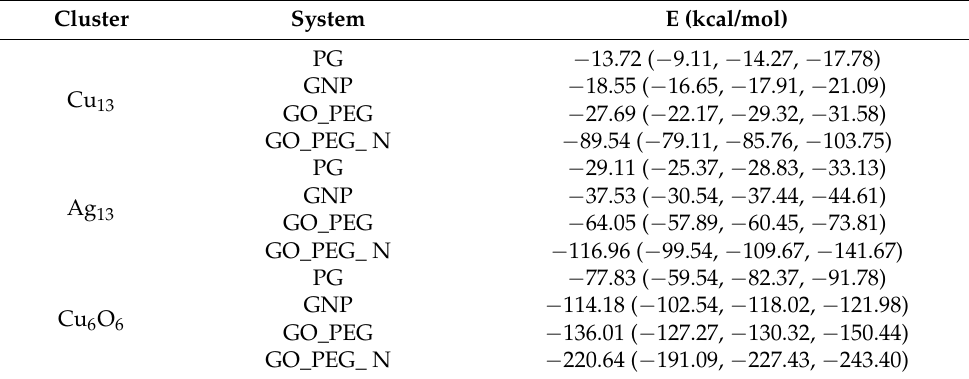
Table 1. Average ∆ E values for the adsorption of Cu, Ag, and CuO nanoclusters on pristine and functionalized graphene-based materials. The values obtained from each individual simulation are shown in